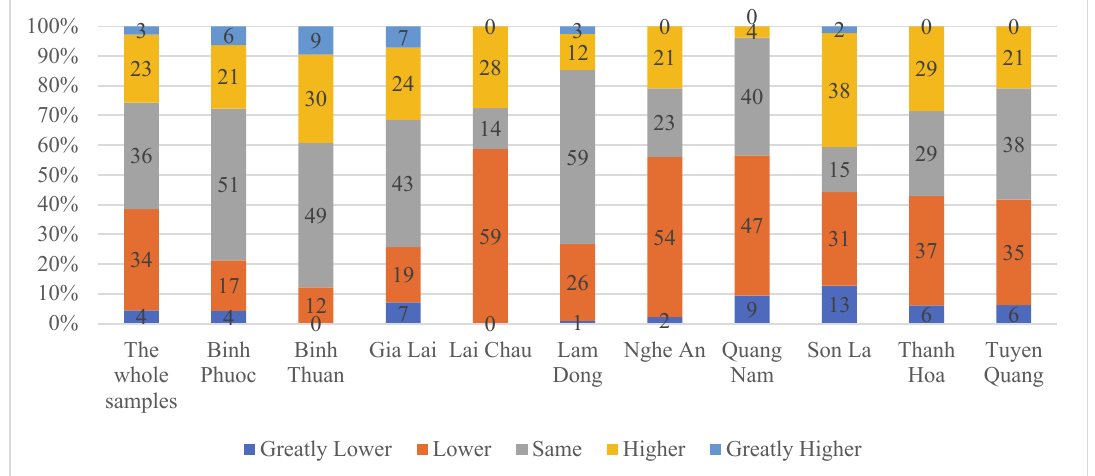
Fig. 1. Proportion of the impact assessment of the resettled households on their income by provinces Source: Authors’ calculation from the survey in